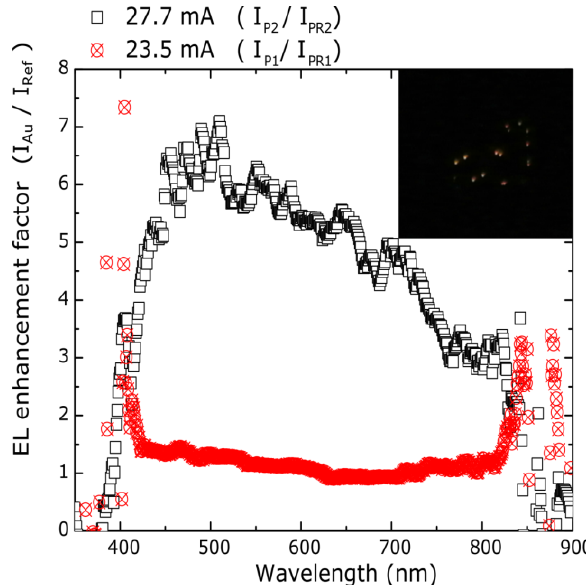
Figure 7. EL enhancement factor (defined as the ratio of EL intensities of samples with gold nanoparticles and their references ones (IP1(λ)/IPR1(λ) and IP2(λ)/IPR2(λ)). The IP1(λ)/IPR1(λ) ratio evaluated through a wavelength range from 430 to 815 nm at 23.5 mA, an almost constant line slightly above one is observed. The IP2(λ)/IPR2(λ) ratio at 27.7 mA shows a maximum EL enhancement factor of 7 at about 510 nm.